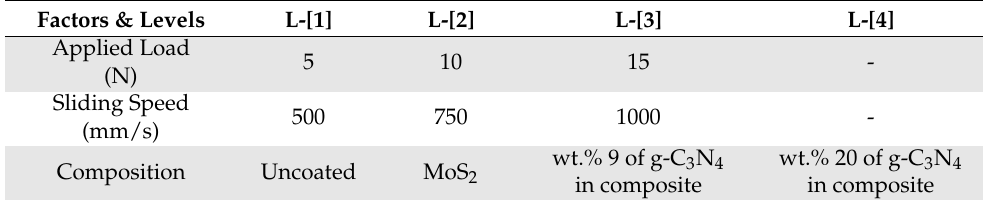
Figure 3. Schematic illustration of the POD tester. The design of experiment (DOE) was created with the help of MINITAB-19, and for the purpose of conducting an analysis, three factors at their different levels were considered. These factors include the applied load, sliding speed, and composition. Table 3 presents the parameters used as inputs in the investigation. Table 3. Parameters utilized as inputs for the